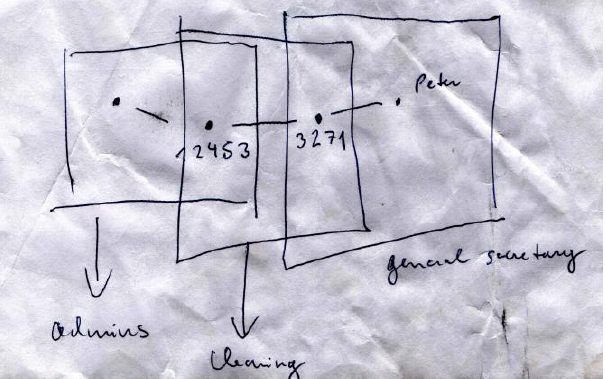
Figure 2: The Three-Boxes Identity Clearing